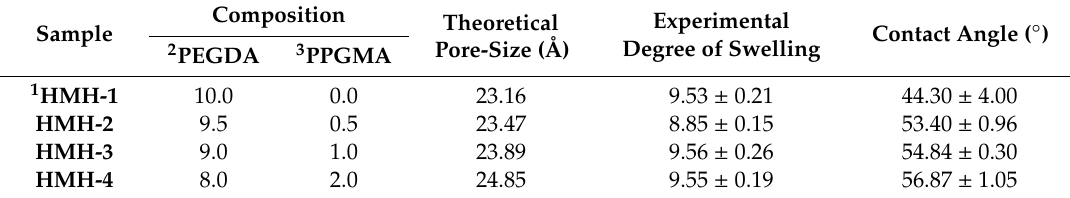
Table 1. Composition and characterization of the hydrophobically-modified hydrogel. Sample